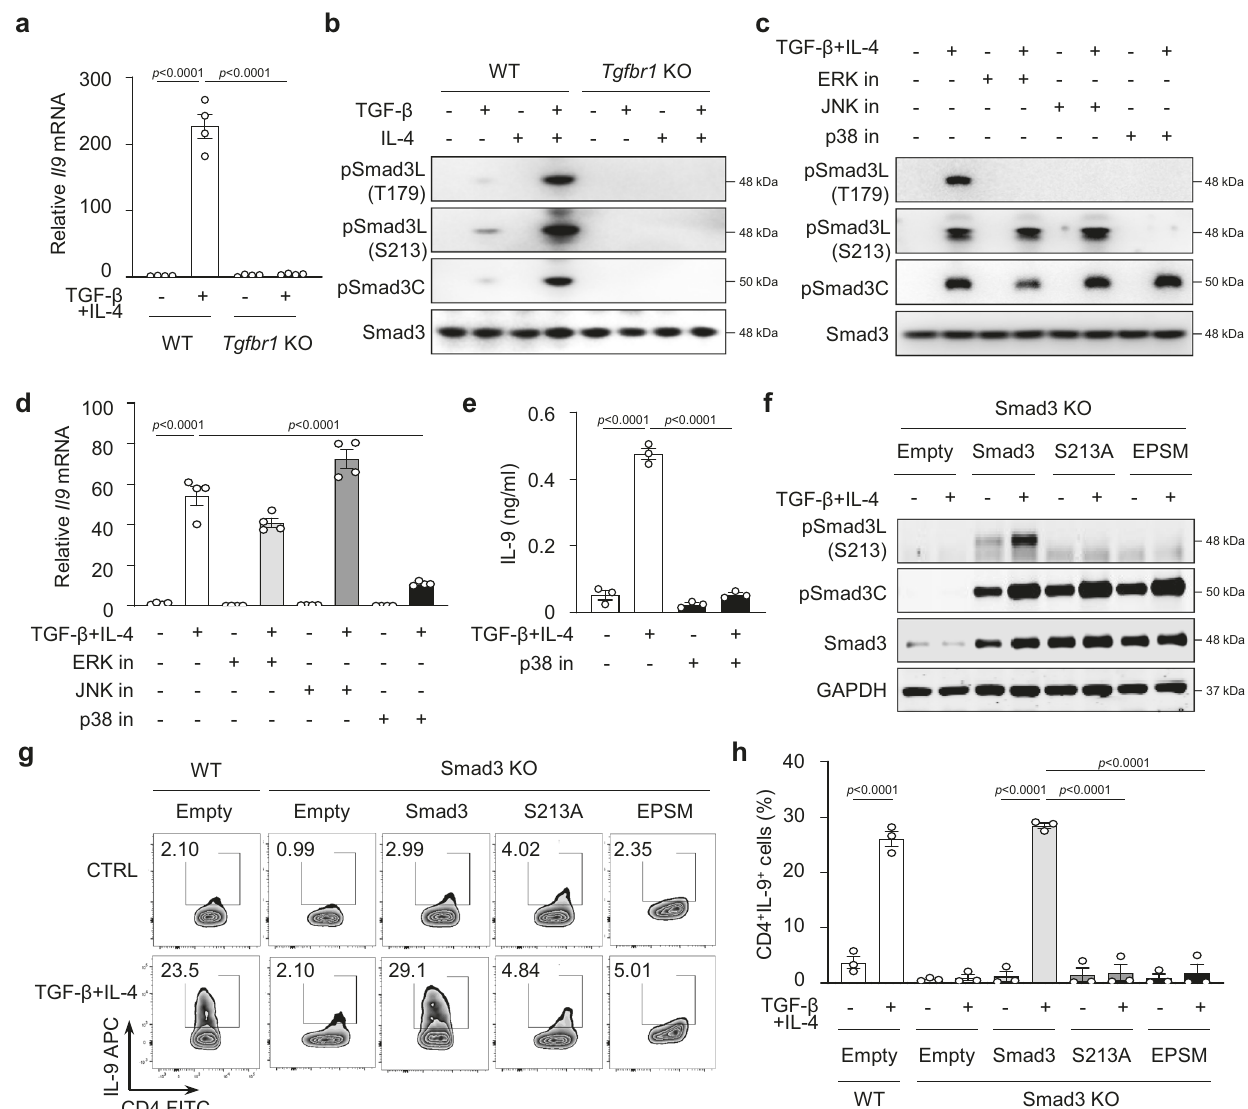
Fig. 1 | Phosphorylation of Smad3 linker Ser 213 site is essential for Th9 differ- entiation by TGF- β and IL-4 stimulation. a Expression of Il9 mRNA in naïve CD4 + T cells from Tgfbr1 f/f ER - cre + mice that had been treated with Oil (WT) or tamoxifen ( Tgfbr1 KO) for 5 days stimulated with TGF- β plus IL-4 for 24h. The results are presented relative to those of the control gene Hprt . b Western blot analysis of phosphorylatedlinkerregionThr 179 (pSmad3L-T179),Ser 213 (pSmad3L-S213)sitesand C-terminal(pSmad3C)ofSmad3andtotalSmad3(Smad3)inWTand Tgfbr1 KOCD4 + T cells cultured with medium, TGF- β , IL-4 or TGF- β plus IL-4 for 2h. c Western blotting of Smad3 phosphorylation in normal CD4 + T cells pre-treated with the indicated inhibitors and then cultured with TGF- β plus IL-4 for 2h. d Real time RT- PCR analysis of Il9 mRNA in CD4 + T cells pre-treated with the indicated inhibitors as